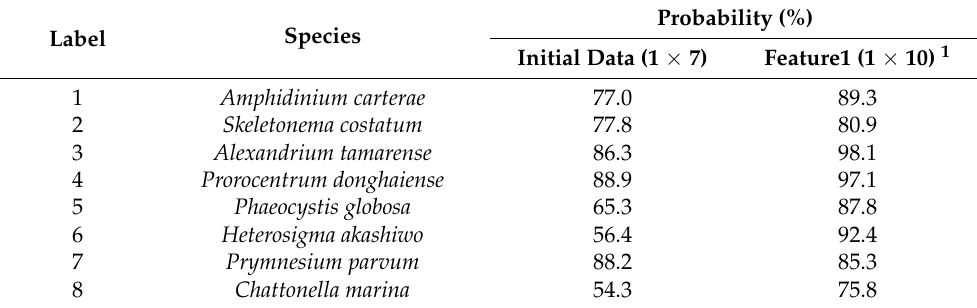
Table 4. Comparison of discriminant probabilities of different algae by adding